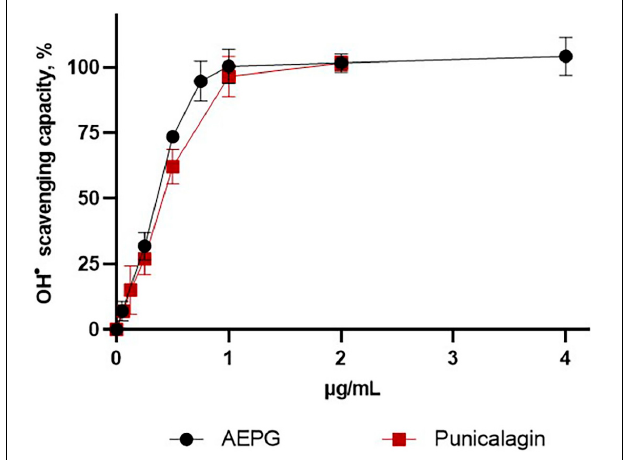
FIGURE 5 | Hydroxide radical (OH)-scavenging capacity of AEPG, commercial punicalagin, and ellagic acid in a chemical combinatorial system. Ellagic acid had no effect. Data are represented as mean values ± S.E.M. of four to six experiments per concentration.